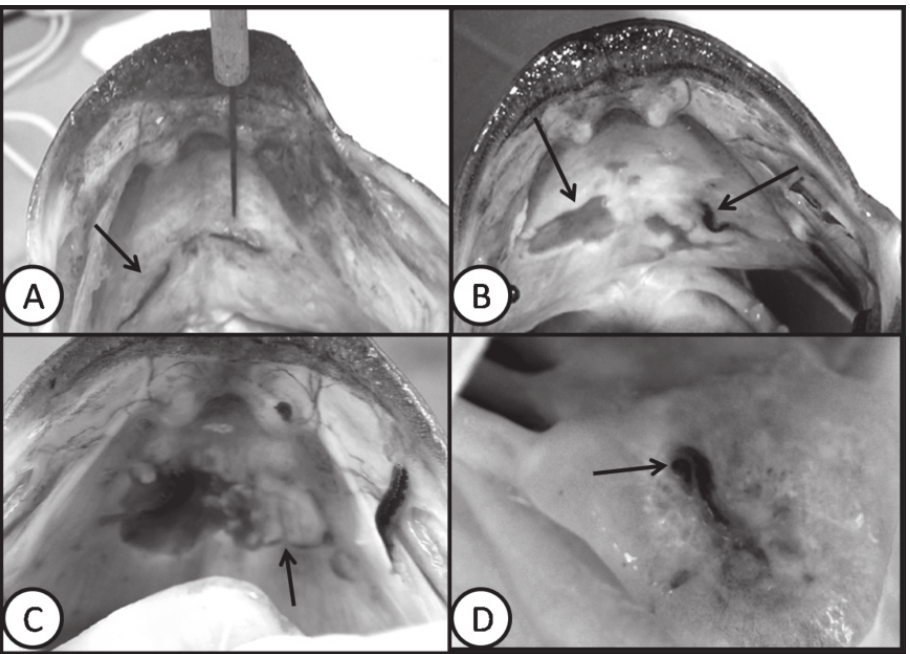
Fig. 3. – Myzobdella lugubris . (A) burrowing into the buccal mucosa of a largemouth bass (arrow) from Orion Lake; (B) ulcerations and leeches (arrows) in the roof of the mouth of a largemouth bass from Orion Lake; (C) severe ulceration associated with a leech infestation in the roof of the mouth of a largemouth bass from Devils Lake with suppurative inflammation and subsequent pus formation (arrow); and (D) M. lugubris (arrow) attached to the tongue of a largemouth bass from Devils